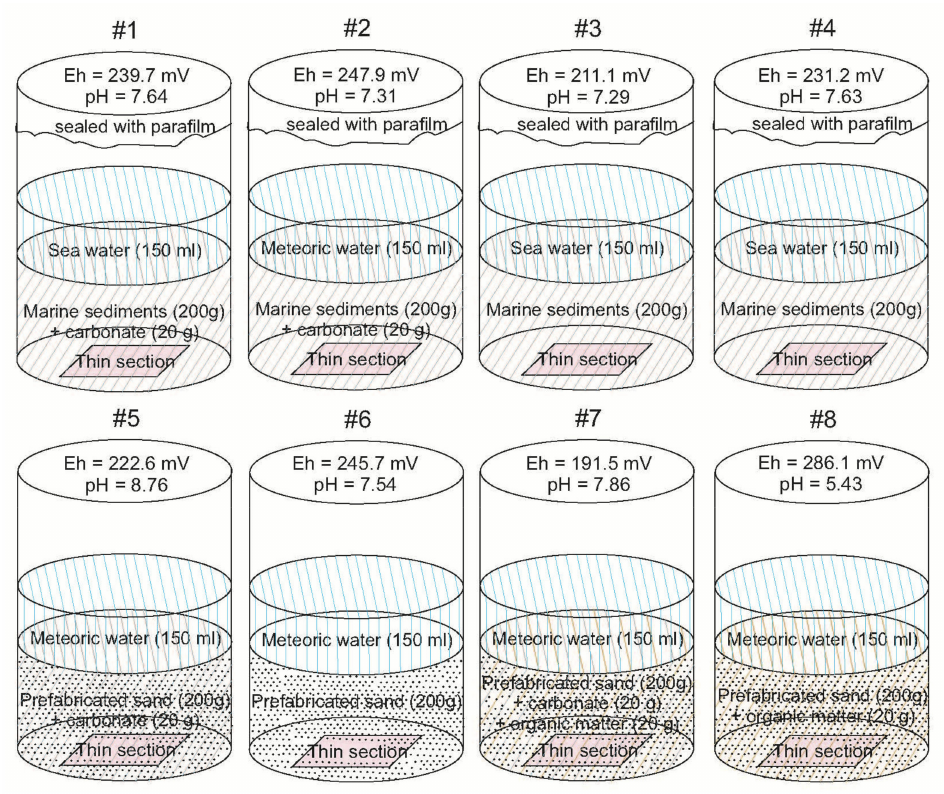
Figure 3. Schematic presentation of test settings #1–#8 conditions. Eh and pH are measured in sediments before the tests. See text for